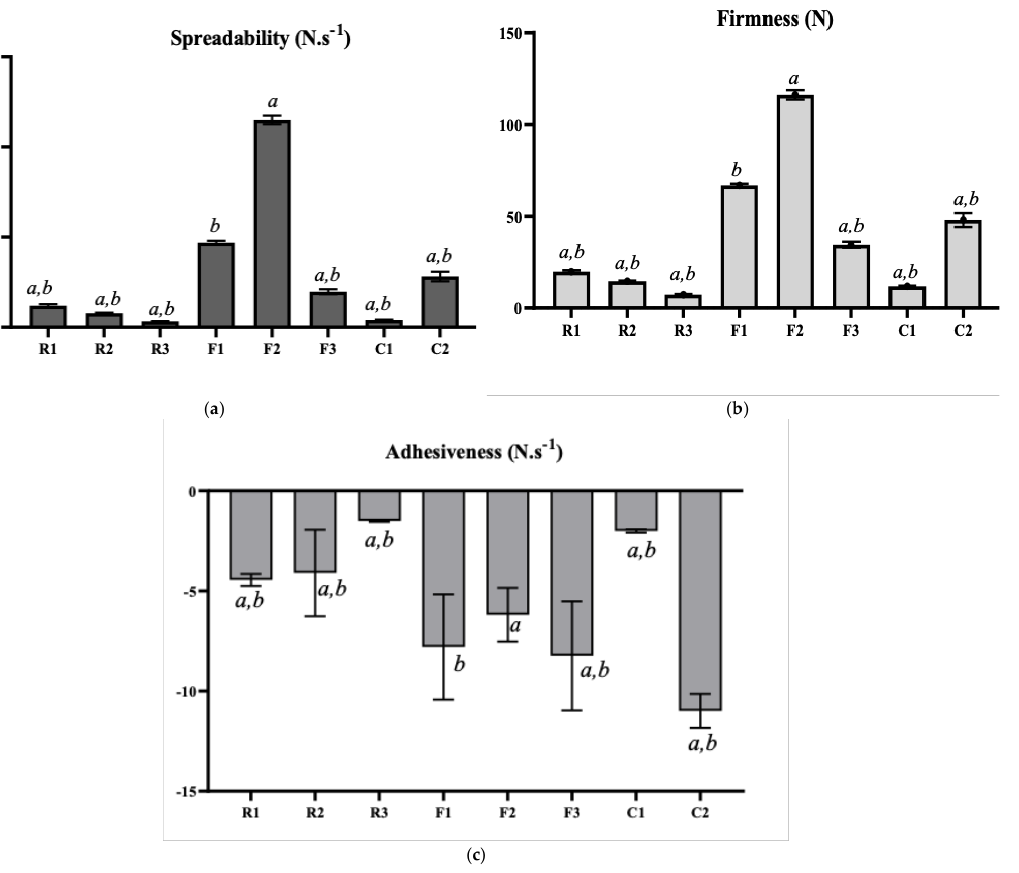
Figure 5. Texture analysis of final peanut butter samples. Values were significantly ( p < 0.05) different for using rice bran wax oleogel in sample F1; b = values were significantly ( p < 0.05) different for using carnauba wax oleogel in sample F2. R1 = rice bran wax added sample; R2 = carnauba wax added sample; R3 = un-stabilized butter from natural peanut (control); F1 = rice bran wax oleogel added sample; F2 = carnauba wax oleogel added sample; F3 = un-stabilized butter from peanut flour; C1 = commercial natural peanut butter; C2 = commercial creamy peanut